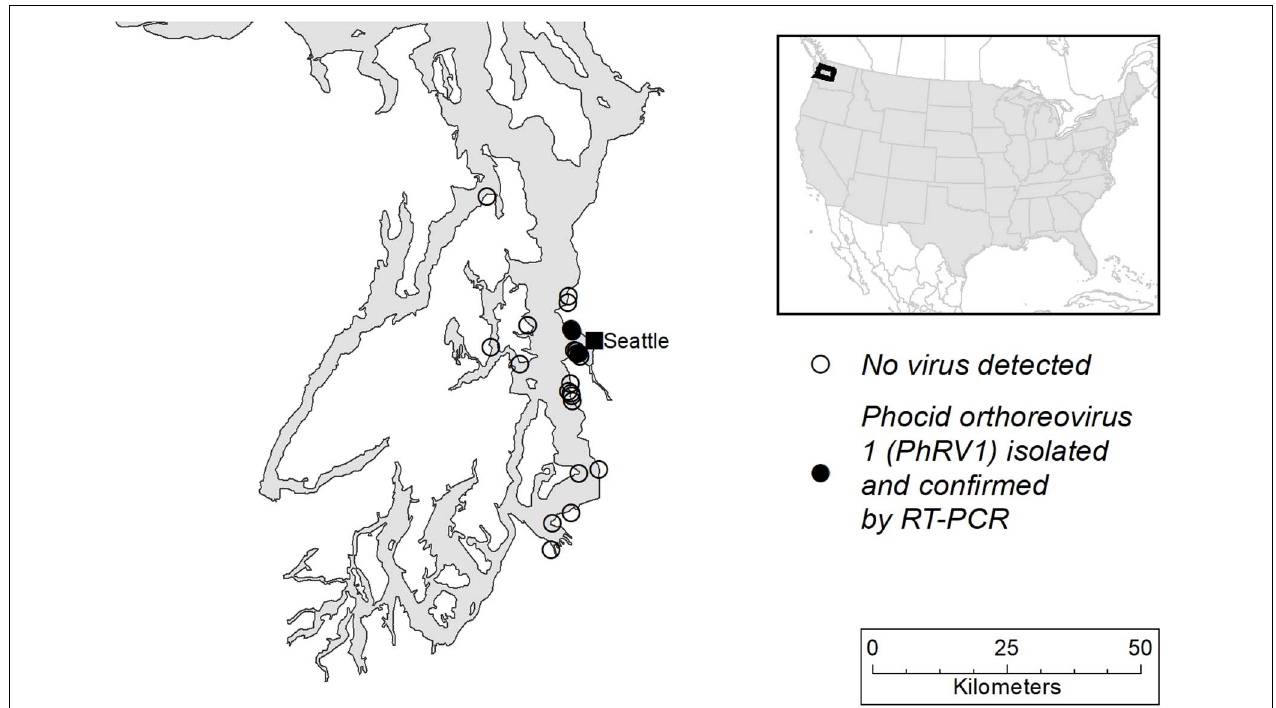
FIGURE 1 | Map of Puget Sound, Washington State, United States showing the sites where seal carcasses were